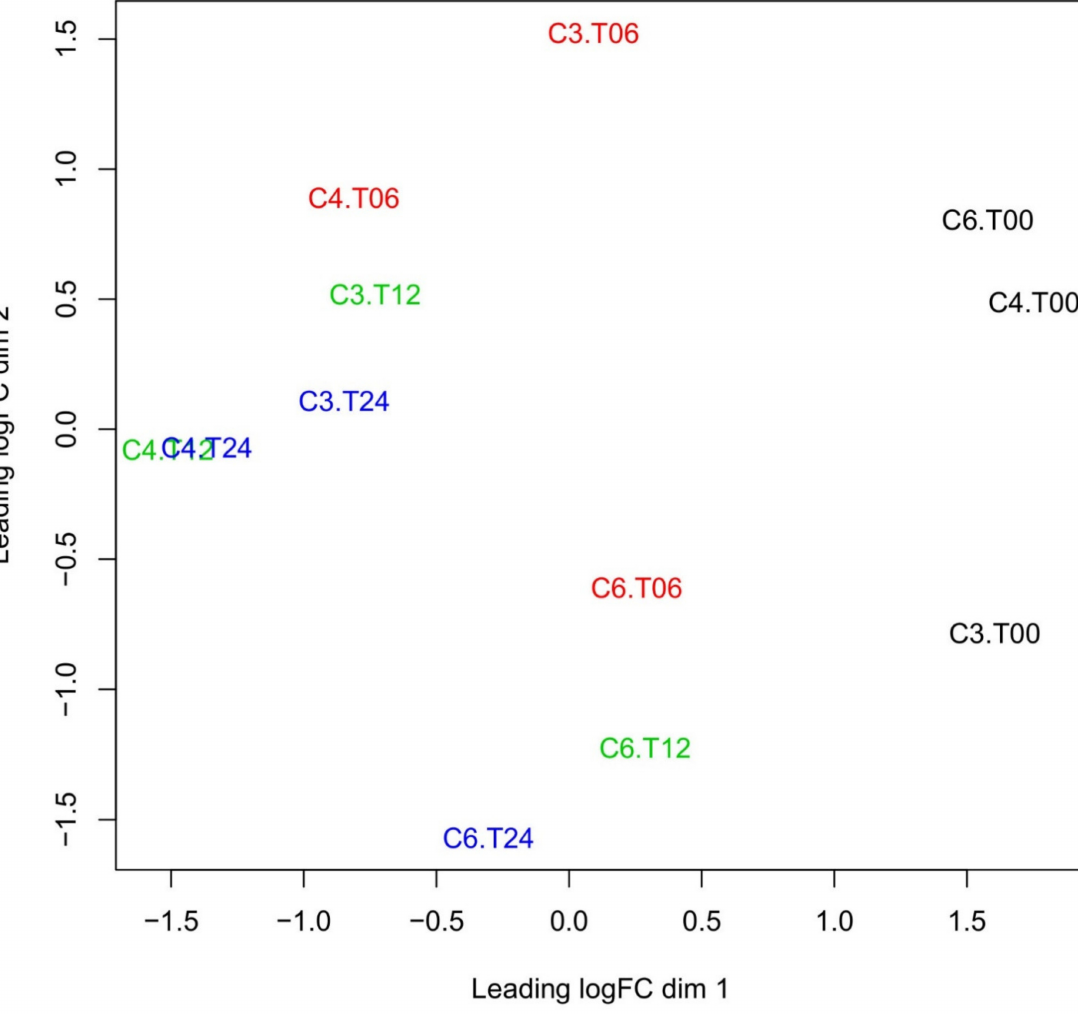
Figure 1. Multidimensional scaling (MDS) analysis of transcription log-fold changes. Each label corresponds to a camel (C) and a time point (T). There are three camels (C3, C4, and C6) and four times (T) points: 0, 6, 12, and 14 h post-vaccination). MDS analysis shows a detectable change in the overall gene regulation after vaccination. Change in time occurs mostly along the leading MDS dimension 1 (x-axis). An individual effect is observed (mostly along the second MDS dimension 2, y-axis). Regulation at each time point is similar for all camels, leading to points for the same time (black = 0 h, red = 6 h, green = 12 h, blue = 24 h after vaccination) being relatively clustered together. However, some exceptions do exist, notably for camel